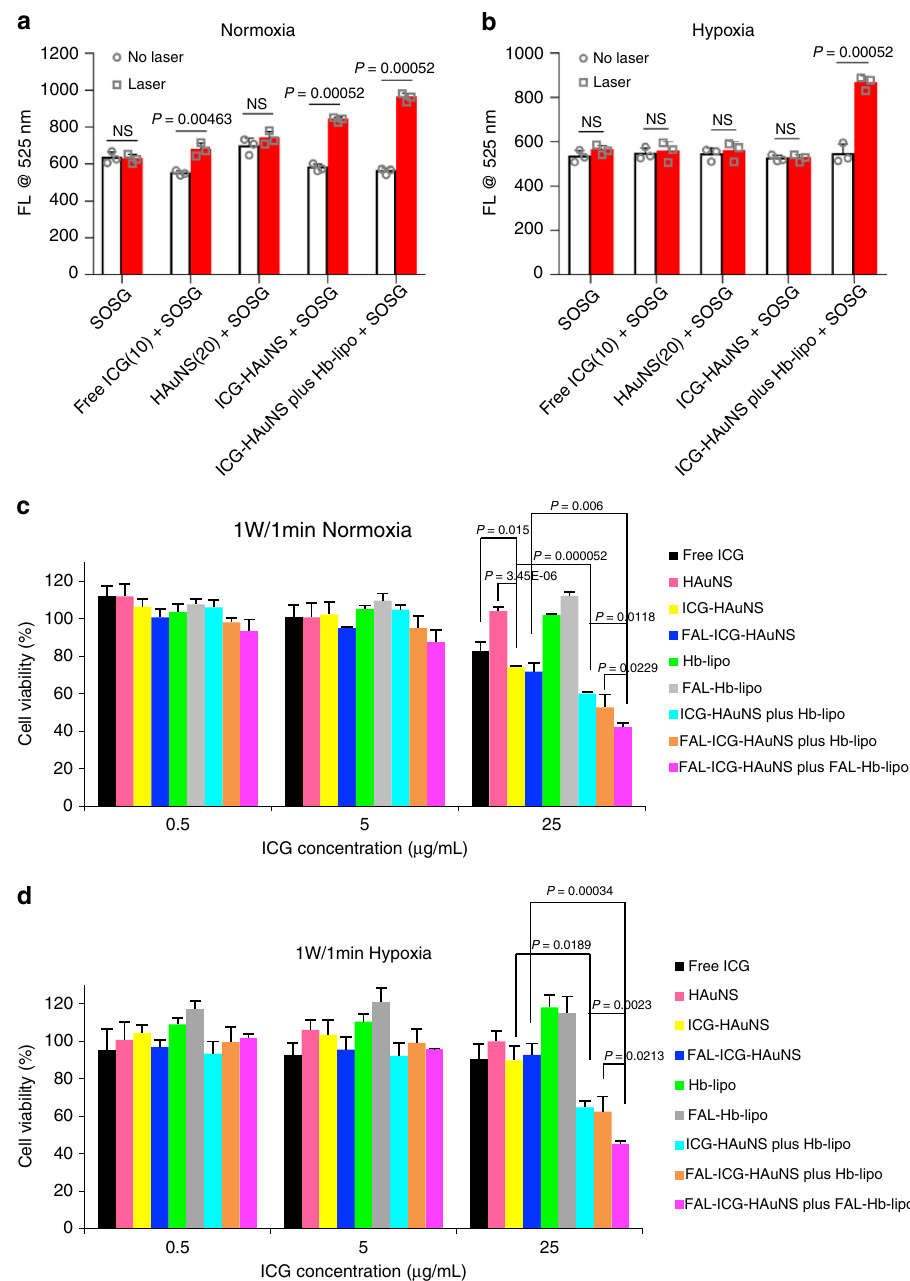
Fig. 3 Reactive oxygen species (ROS) generation and antitumor effect in vitro. a ROS generation in free indocyanine green (ICG; 10 μ g/mL), hollow gold nanospheres (HAuNS; 20 μ g/mL), ICG-HAuNS (ICG: 10 μ g/mL; HAuNS: 20 μ g/mL), or ICG-HAuNS plus Hb-lipo (ICG: 10 μ g/mL; HAuNS: 20 μ g/mL; Hb: 20 μ g/mL) treatment groups under normoxia detected with Singlet Oxygen Sensor Green (SOSG). Laser power: 1 W/cm 2 , 10 min, n = 3. b ROS generation in free ICG (10 μ g/mL), HAuNS (20 μ g/mL), ICG-HAuNS (ICG: 10 μ g/mL; HAuNS: 20 μ g/mL), or ICG-HAuNS plus Hb-lipo (ICG: 10 μ g/mL; HAuNS: 20 μ g/mL; Hb: 20 μ g/mL) treatment groups under hypoxia detected with SOSG. Laser power: 1 W/cm 2 , 10 min, n = 5. c , d CT-26 cell viability after incubation with free ICG, HAuNS, ICG-HAuNS, FAL-ICG-HAuNS, Hb-lipo, FAL-Hb-lipo, ICG-HAuNS plus Hb-lipo, FAL-ICG-HAuNS plus Hb-lipo, or